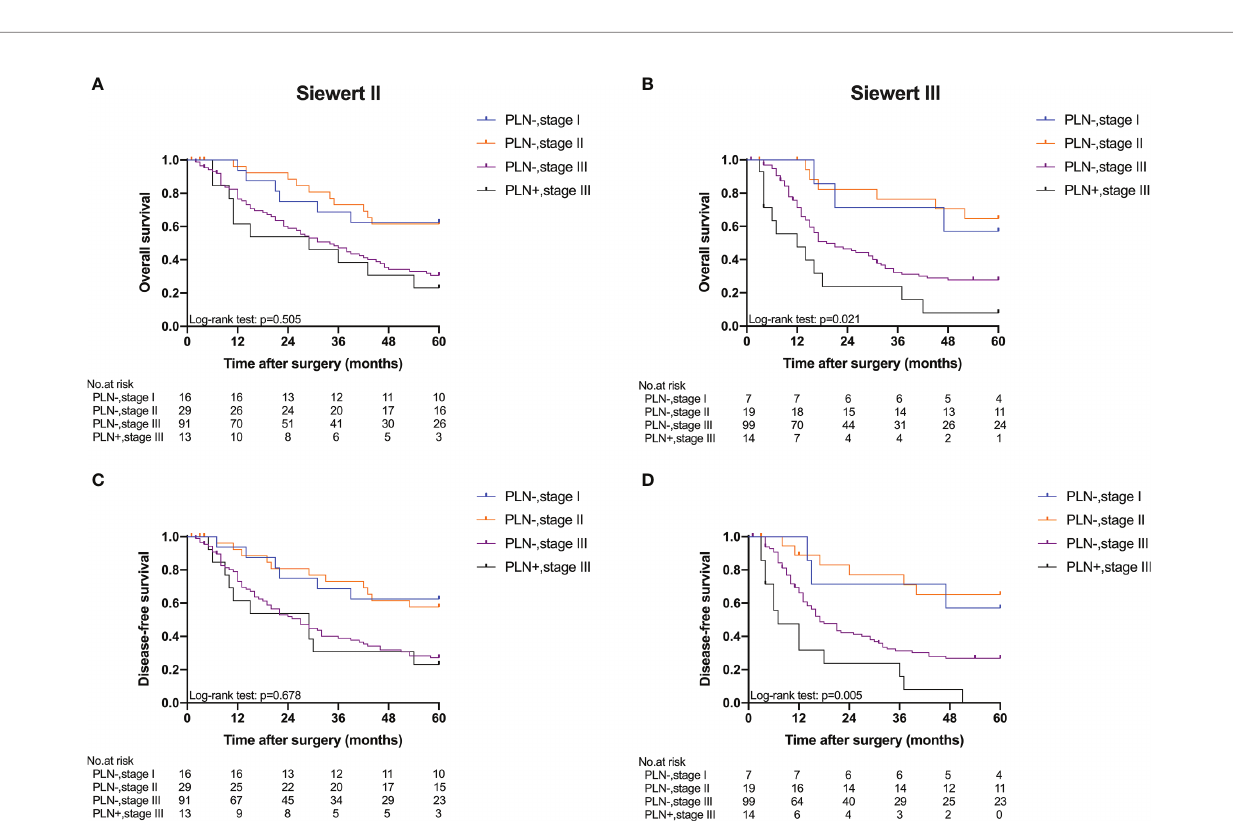
FIGURE 5 | Five-year OS and DFS of Siewert type II and III AEGs classi fi ed by TNM stage and PLN status. (A) OS of Siewert type II, p = 0.505. (B) OS of Siewert type III, p = 0.021. (C) DFS of Siewert type II, p = 0.678. (D) DFS of Siewert type III, p = 0.005 (PLN − , stage III vs. PLN+, stage